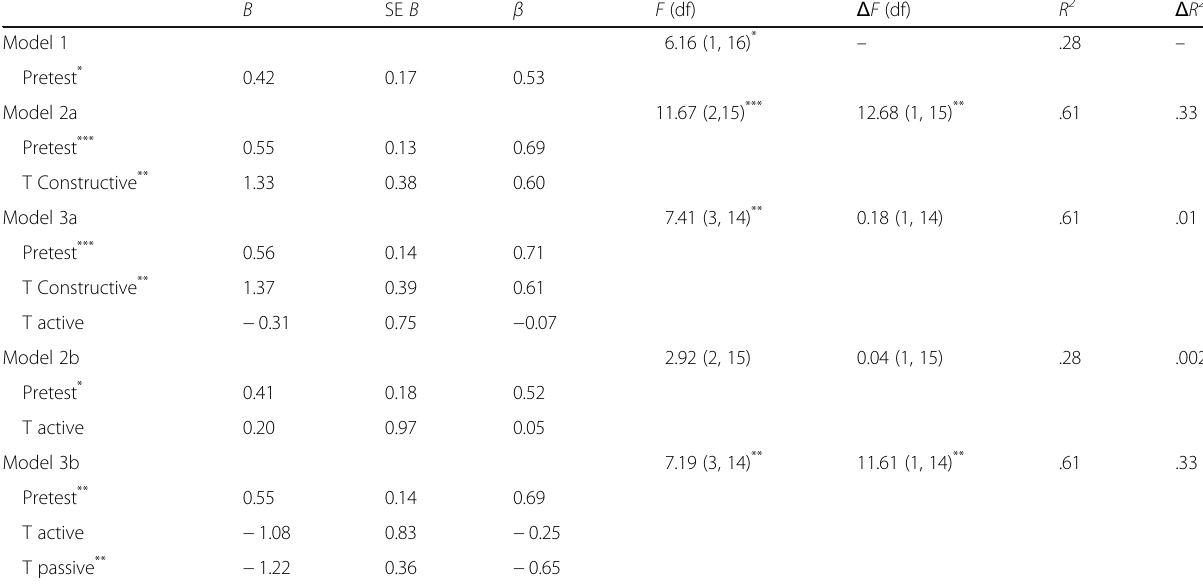
Table 6 Regression models predicting transfer scores from proportions of teacher talk types